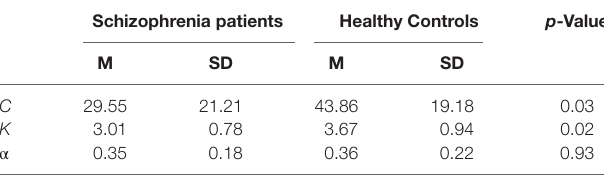
TaBlE 3 | Theory of Visual Attention whole- and partial-report parameters at baseline for the schizophrenia patient and healthy control